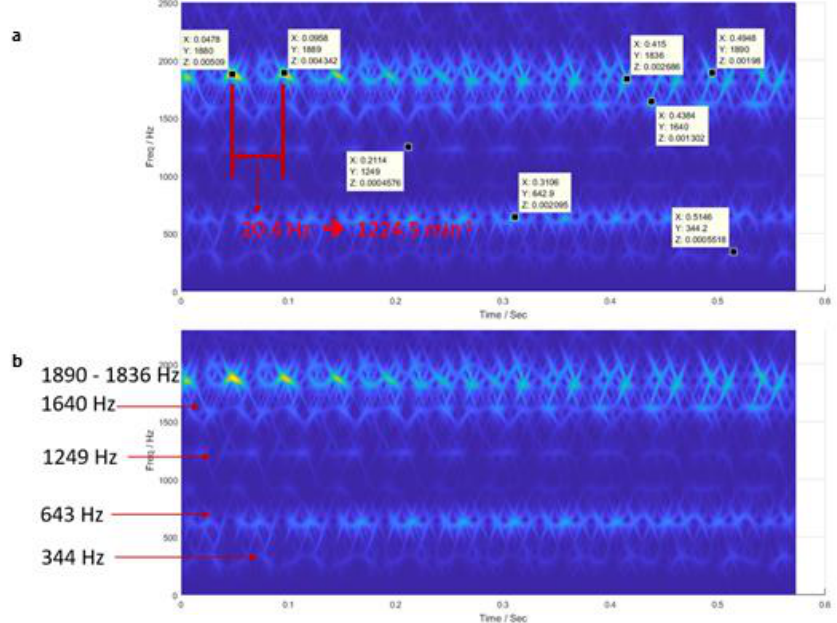
Figure 9. Chirplet time-frequency representation of the harmonic part for 3 honing cycles of experiment 2: ( a ) Values for the marks; ( b ) main frequencies. 2: ( a ) Values for the marks; ( b ) main